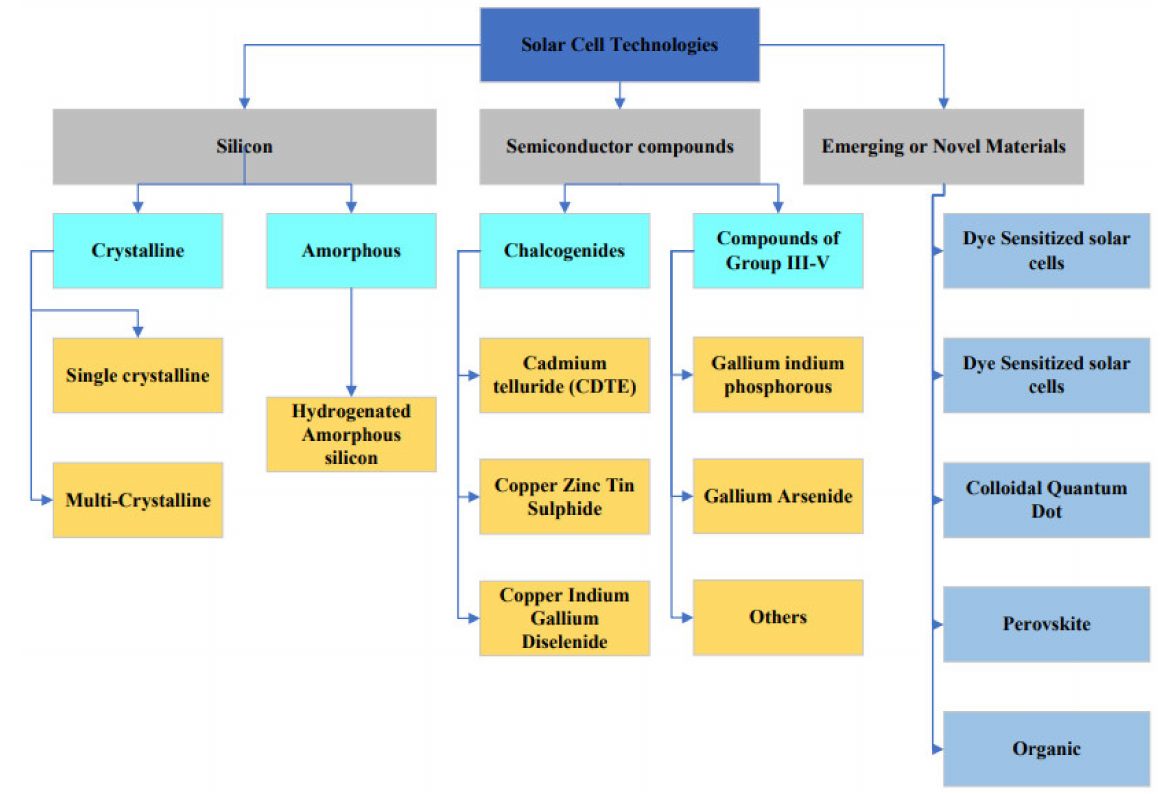
Figure 6. Technologies of solar cells